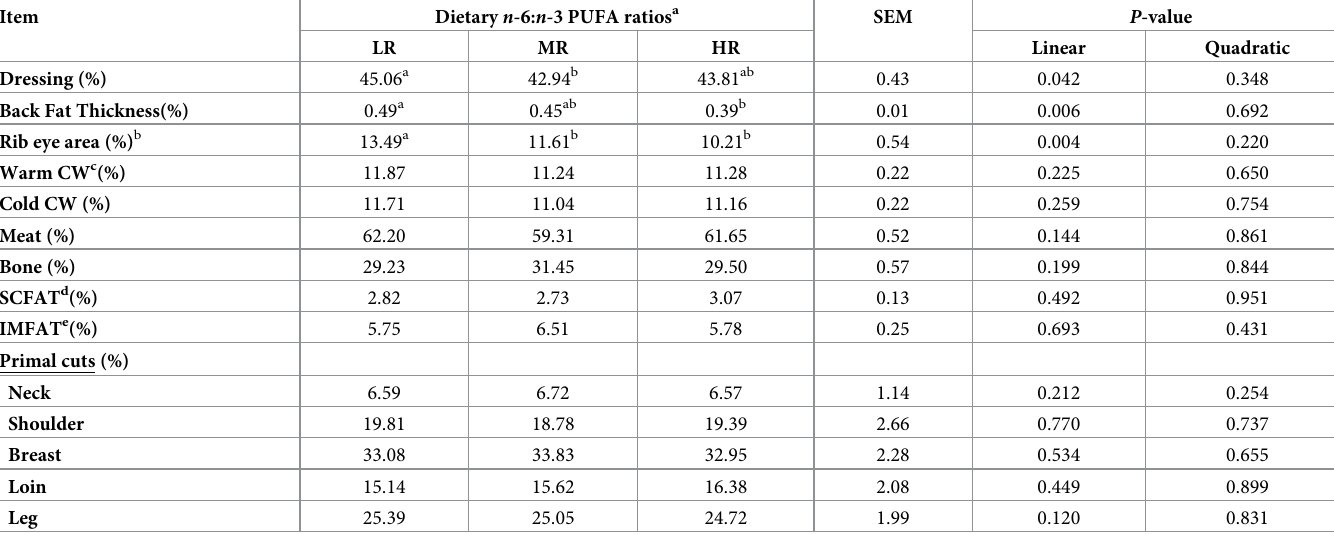
Table 4. Effect of dietary n -6: n -3PUFA ratios on carcass characteristics and primal cuts of goats. Item Dietary n -6: n -3 PUFA ratios a SEM P -value LR